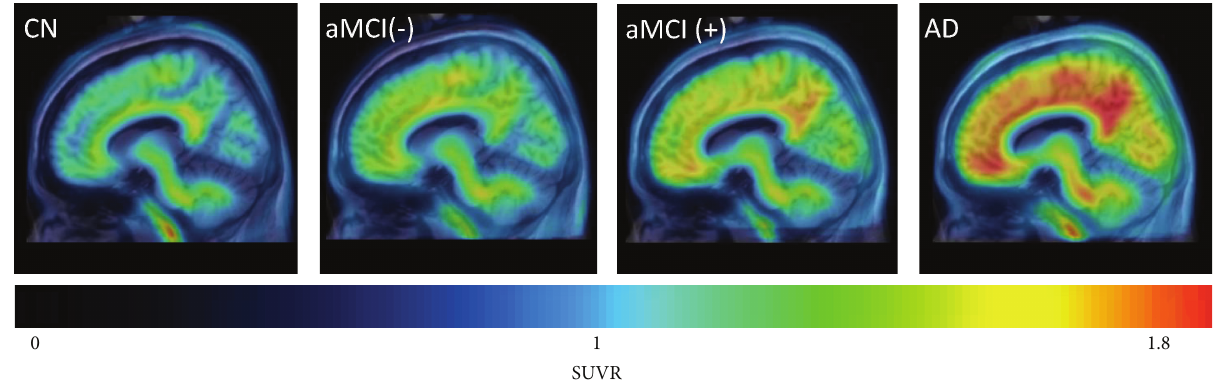
Figure 7: Representative sagittal PET images comparing the standard uptake value ratios (SUVRs) of [ 18 F]florbetapir between cognitively normal (CN), amnestic mild cognitive impairment negative for cerebral A 𝛽 , aMCI( − ), amnestic mild cognitive impairment positive for cerebral A 𝛽 , aMCI(+), and Alzheimer’s disease (AD) patients. Note that higher [ 18 F]florbetapir accumulation was especially prominent in parietal, temporal, and occipital gyri. This study also concluded that there was a significant difference between scores on the Mini Mental State Examination for neurocognitive testing and [ 18 F]florbetapir SUVRs amid CN, aMCI( − ), aMCI(+), and AD subjects ([56], reprinted with